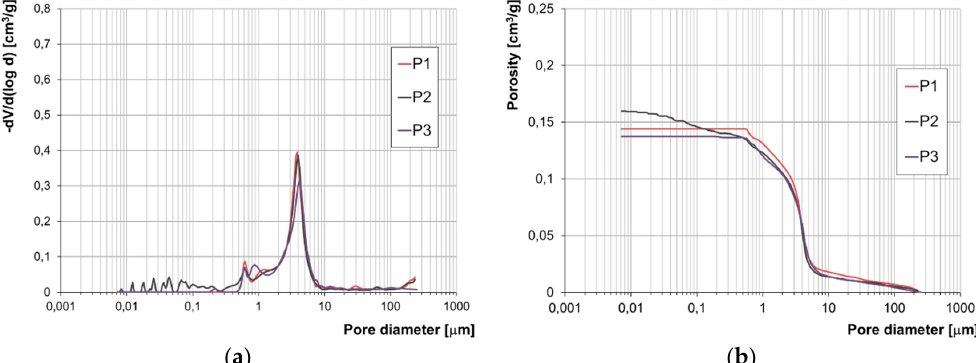
Figure 7. Pore size distribution ( a ) and cumulative curves of pores volume distribution ( b ) for powdering bricks P1, P2 and P3.